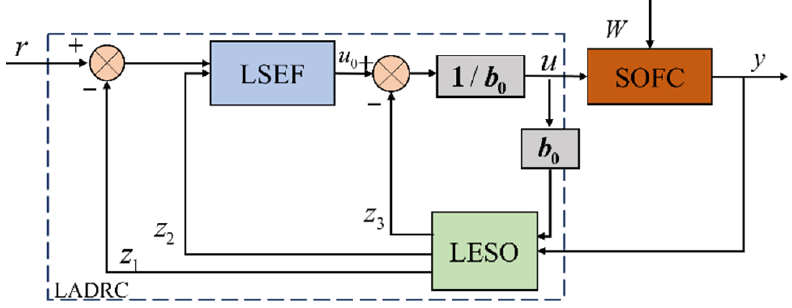
Figure 3. Block diagram of second-order LADRC controller structure.